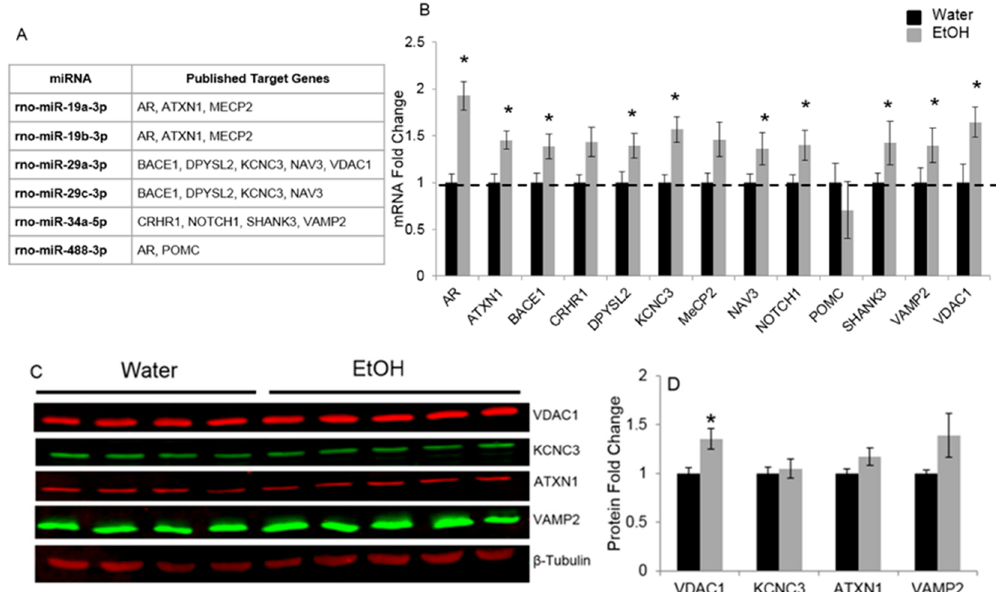
Figure 4. Ethanol treatment during peri-puberty alters validated mRNA targets of EtOH-sensitive microRNAs (miRs) at PND 44. ( A ) Table of published validated mRNA targets for identified EtOH-sensitive miRs. ( B ) mRNA expression levels in the ventral hippocampus of male rats at PND 44 following repeated binge-pattern EtOH administration paradigm during peri-puberty. Data analyzed by ∆∆ Ct method and depicted as mean ± SEM. N = 10/group, an (*) indicates p < 0.05. ( C ) Western blot and ( D ) relative quantification of protein expression in ventral hippocampus tissue of the target mRNAs increased by EtOH. Data depicted as relative mean compared to β -Tubulin ± SEM, N = 5/group, an (*) indicates p < 0.05.